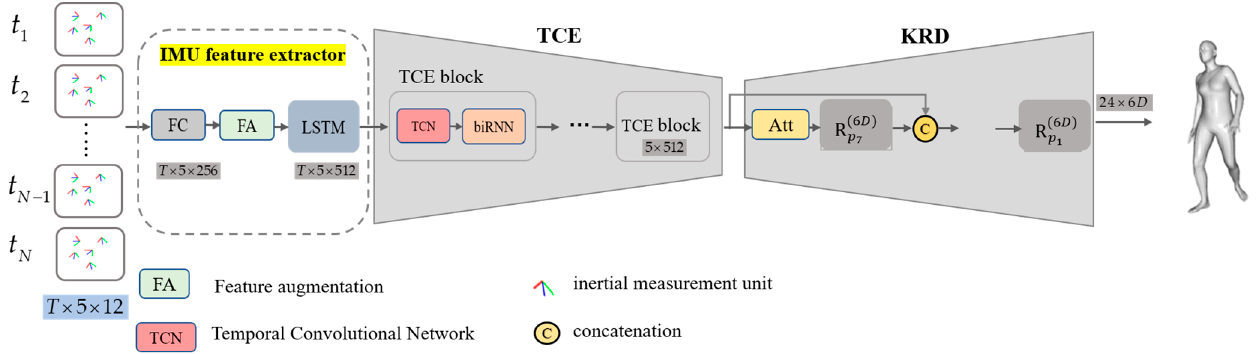
Figure 3. Overview of our proposed framework for human pose estimation from sparse IMUs. Our network framework is divided into three parts. The first part linearly encodes the IMU measurement data and combines the difference between two consecutive frames with the position feature to enhance the feature. The second part is the temporal encoder, which extracts feature information from past and future frames and contains several cascaded blocks. The third part is the kinematic regression decoder, which generates the pose parameters using hierarchical regression defined by the human motion tree.